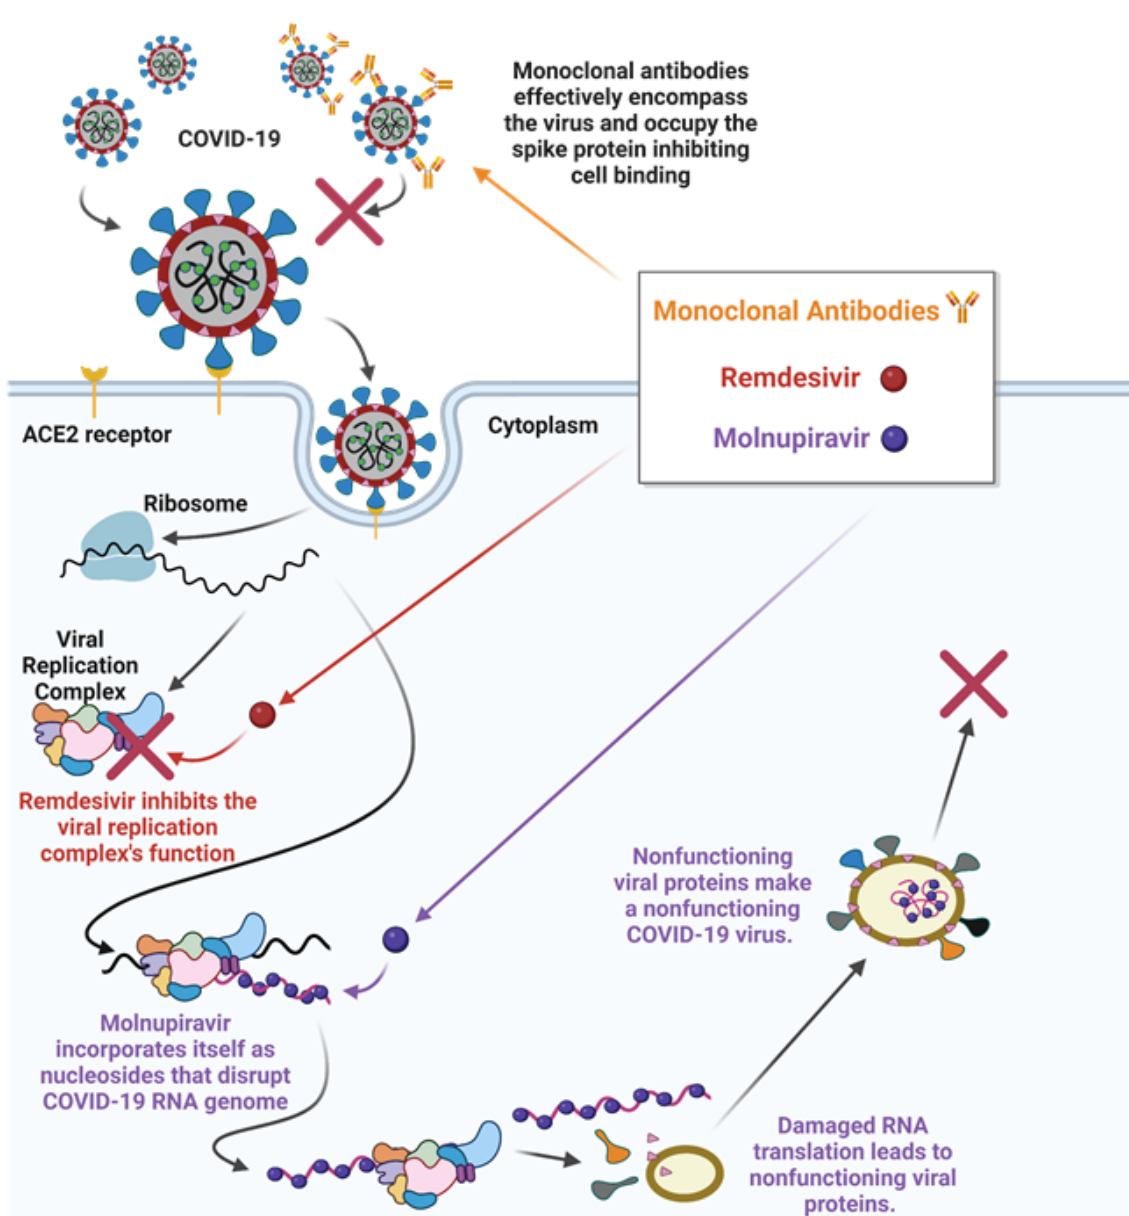
Figure 5: Modes of action of a variety of drugs such as monoclonal antibodies, Remdesivir, and Mol- nupiravir, against COVID-19. Whereas monoclonal antibodies encompass COVID-19 and occupy the spike protein inhibiting cell binding, Remdesivir block the COVID-19 replication process in a human host cell. Molnupiravir, an oral drug, enters a host cell that is infected by actively replicating COVID-19 vi- ruses, in which it acts as a nucleoside analog that can insert itself into the viral RNA genome. These insertions limit/destroy the original translational function of the genome and lead to the creation of non- functioning COVID-19 proteins that inhibit the virus’s ability to replicate and transmit to others. Retrieved and revised from